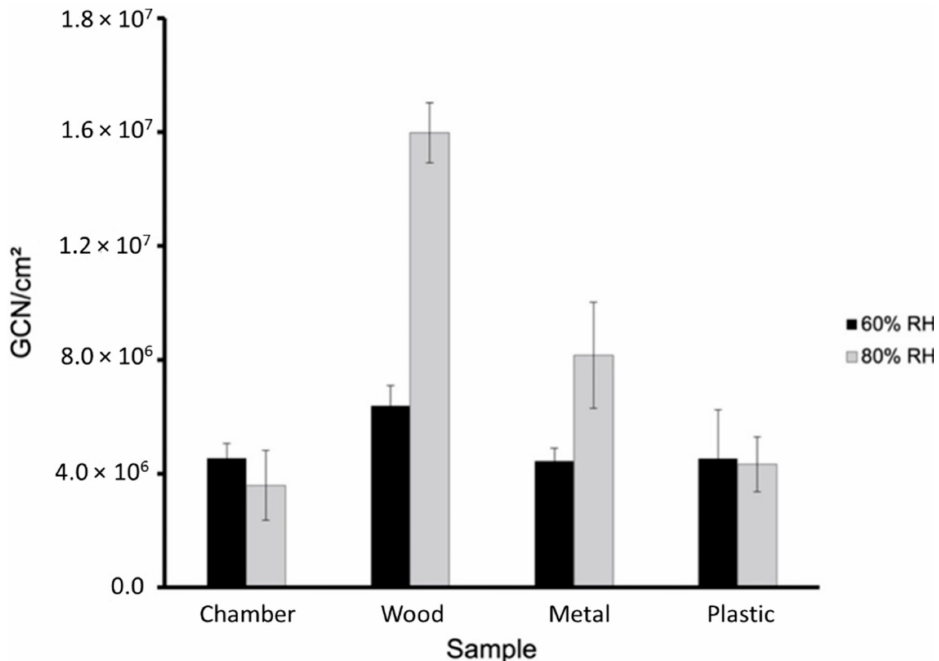
Figure 8. GCN/cm 2 of BCoV at 25 ◦ C and 60% and 80% relative humidity of the chamber swab, the wood, metal, and plastic surface swab samples (Table S2 in Supplementary Material). The results of BCoV association, Figure 9, and dissociation, Figure 10, to surfaces were obtained using the BLItz system. Figure 9 shows the association constant for wood, metal, and plastic surface swab samples at 60% and 80% relative humidity. The k a values of the wood, metal, and plastic swab samples are 8.733 × 10 6 Ms − 1 , 6.948 × 10 6 Ms − 1 , and 9.842 × 10 6 Ms − 1 for 60% relative humidity and 7.749 × 10 6 Ms − 1 , 8.658 × 10 6 Ms − 1 , and 1.065 × 10 7 Ms − 1 for 80% relative humidity, respectively.